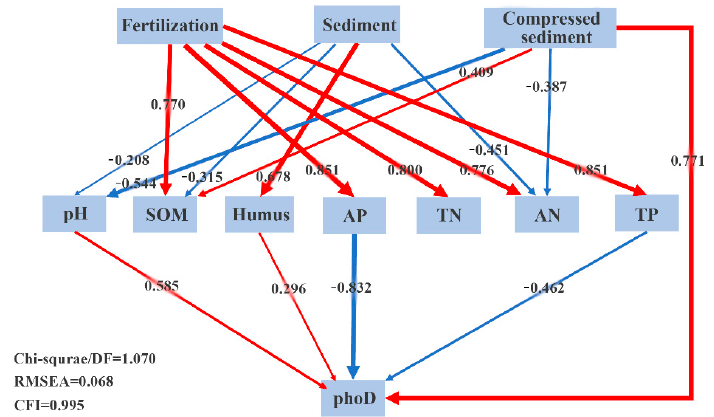
Figure 6. Structural equation model (SEM) analysis of the influences of fertilization on phoD abundance as mediated by soil physicochemical properties. Numbers adjacent to arrows are standardized path coefficients. Red and blue arrows indicate positive and negative effects with significance, respectively.